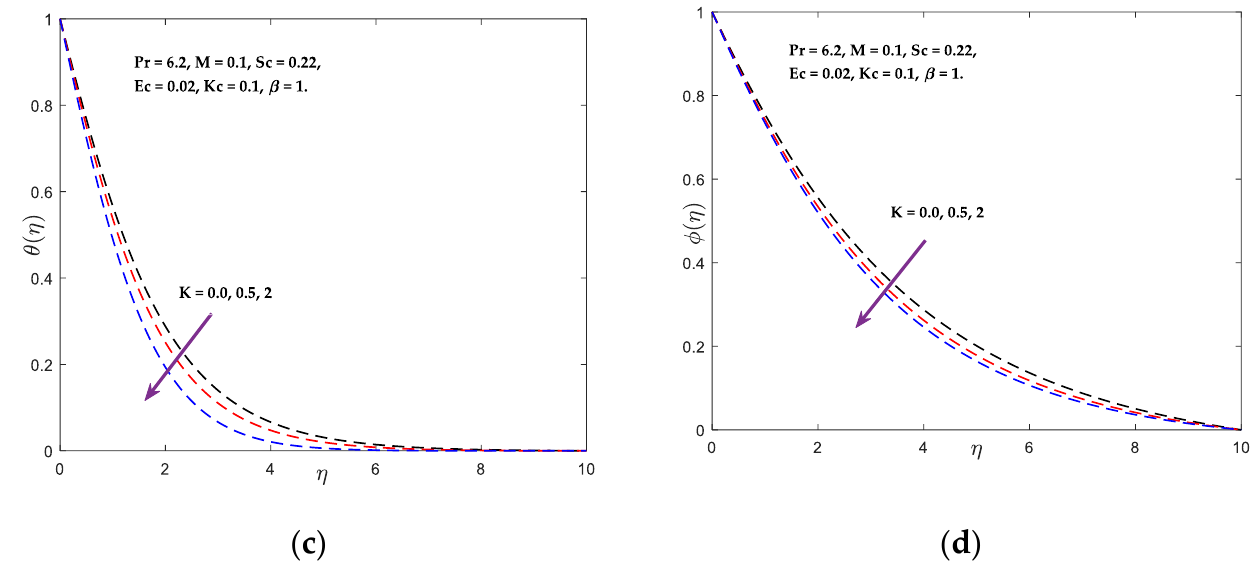
Figure 3. ( a ) Rapidity, ( b ) Angular rapidity, ( c ) Temperature, and ( d ) Concentricity vs. K .